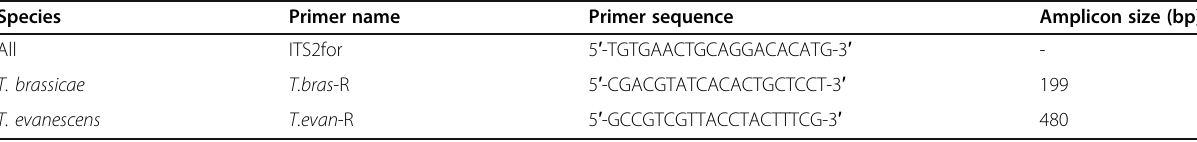
Table 1 PCR primers used in the species-specific multiplex PCR. Primers were designed in the Primer3 (v.0.4.0) software (Rozen and Skaletsky, 2000) from complete sequences of ITS2 rRNA